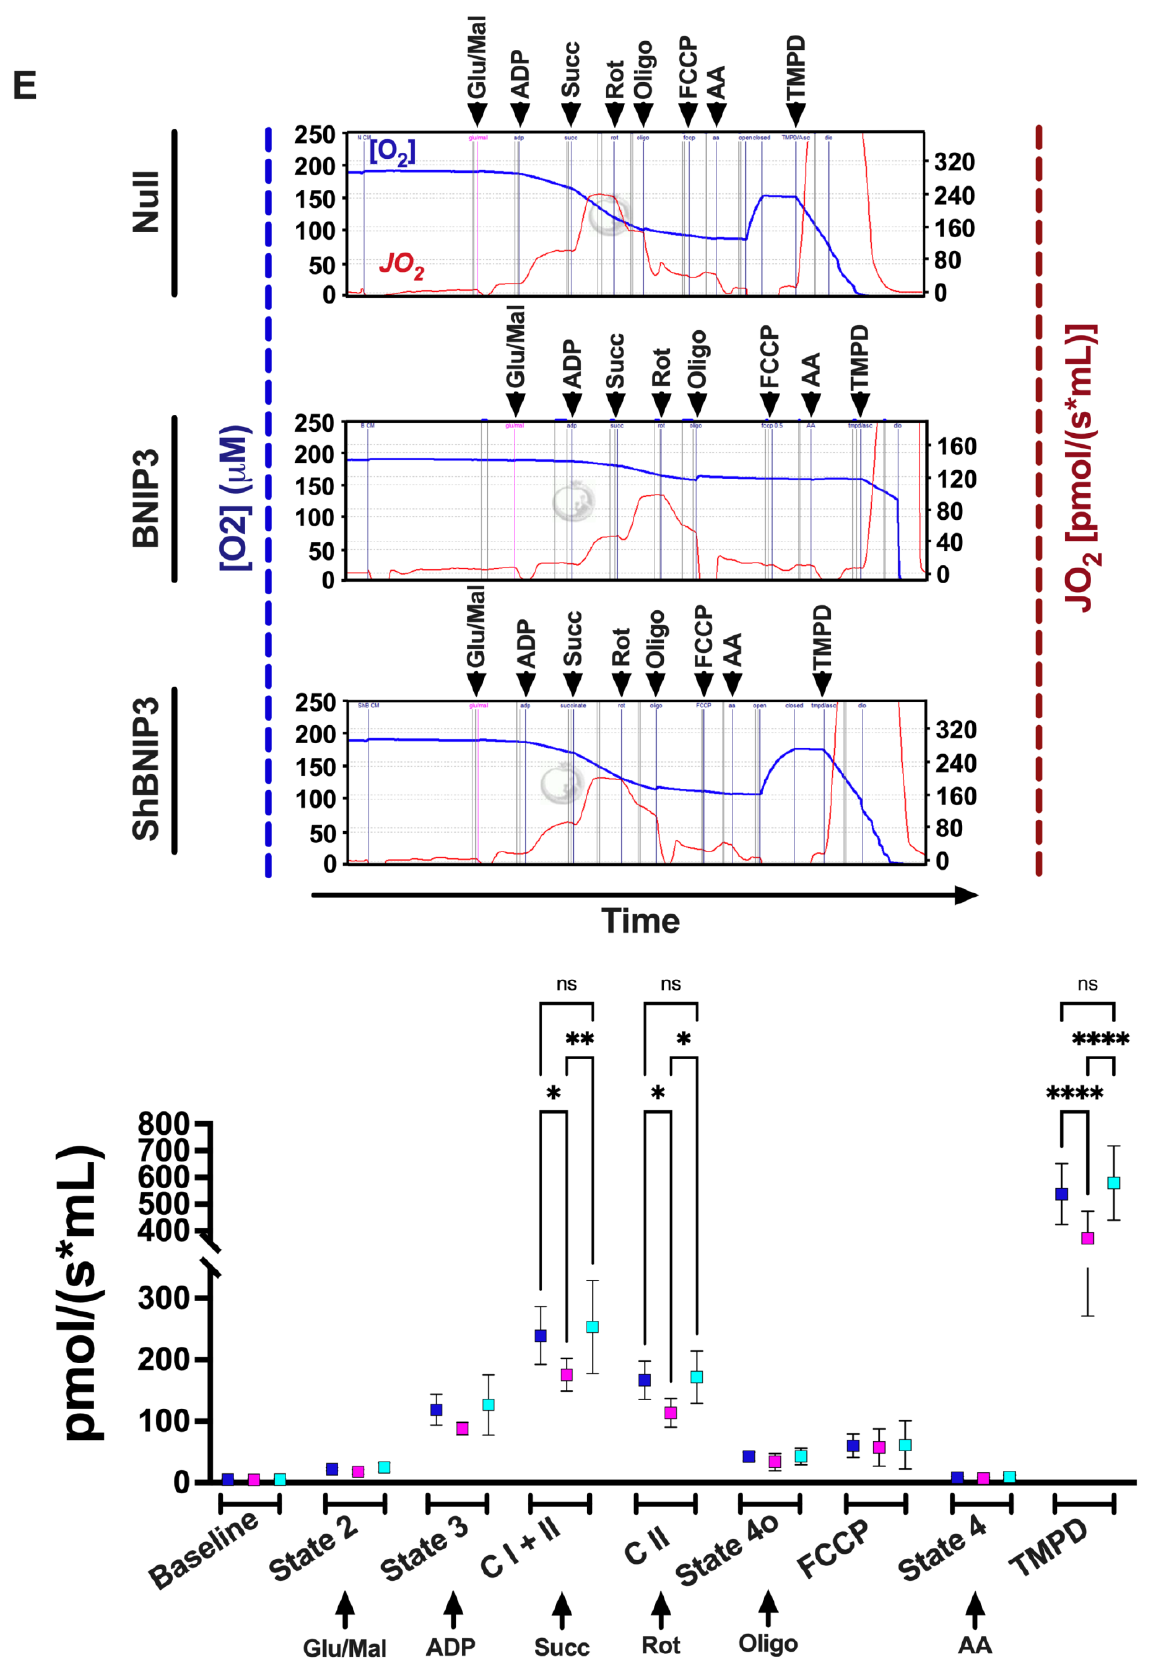
Figure 3. BNIP3 enhances mt-reactive oxygen species production, and attenuates